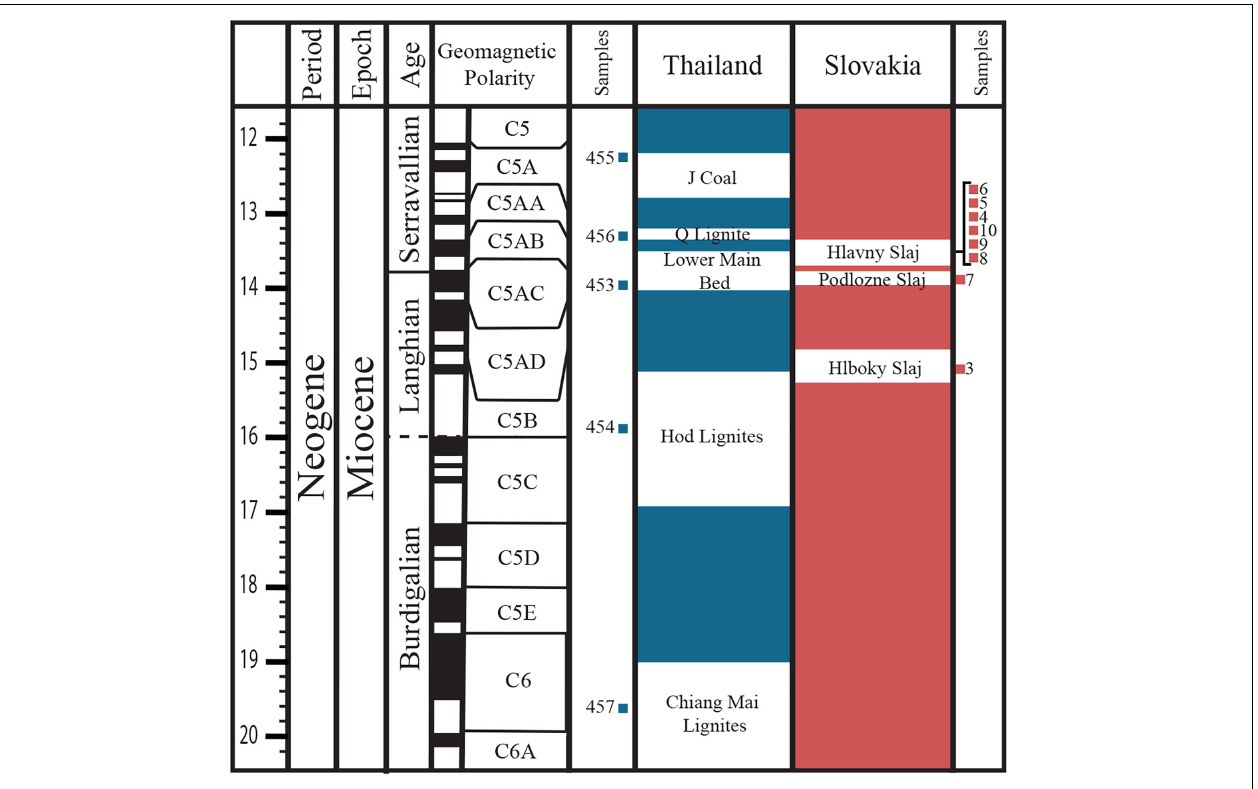
FIGURE 2 | Temporal correlation of the coals from Thailand (blue) and Slovakia